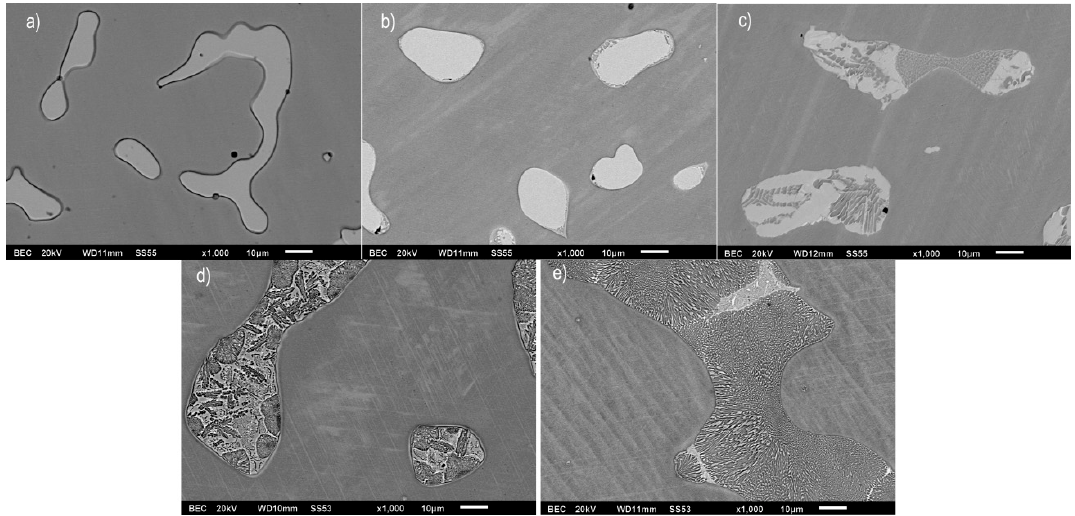
Figure 3. Microstructures after heat treatment; ( a ) 0B-HT, ( b ) 0.06B-HT, ( c ) 0.25B-HT, ( d ) 0.5B-HT and ( e ) 1B-HT.